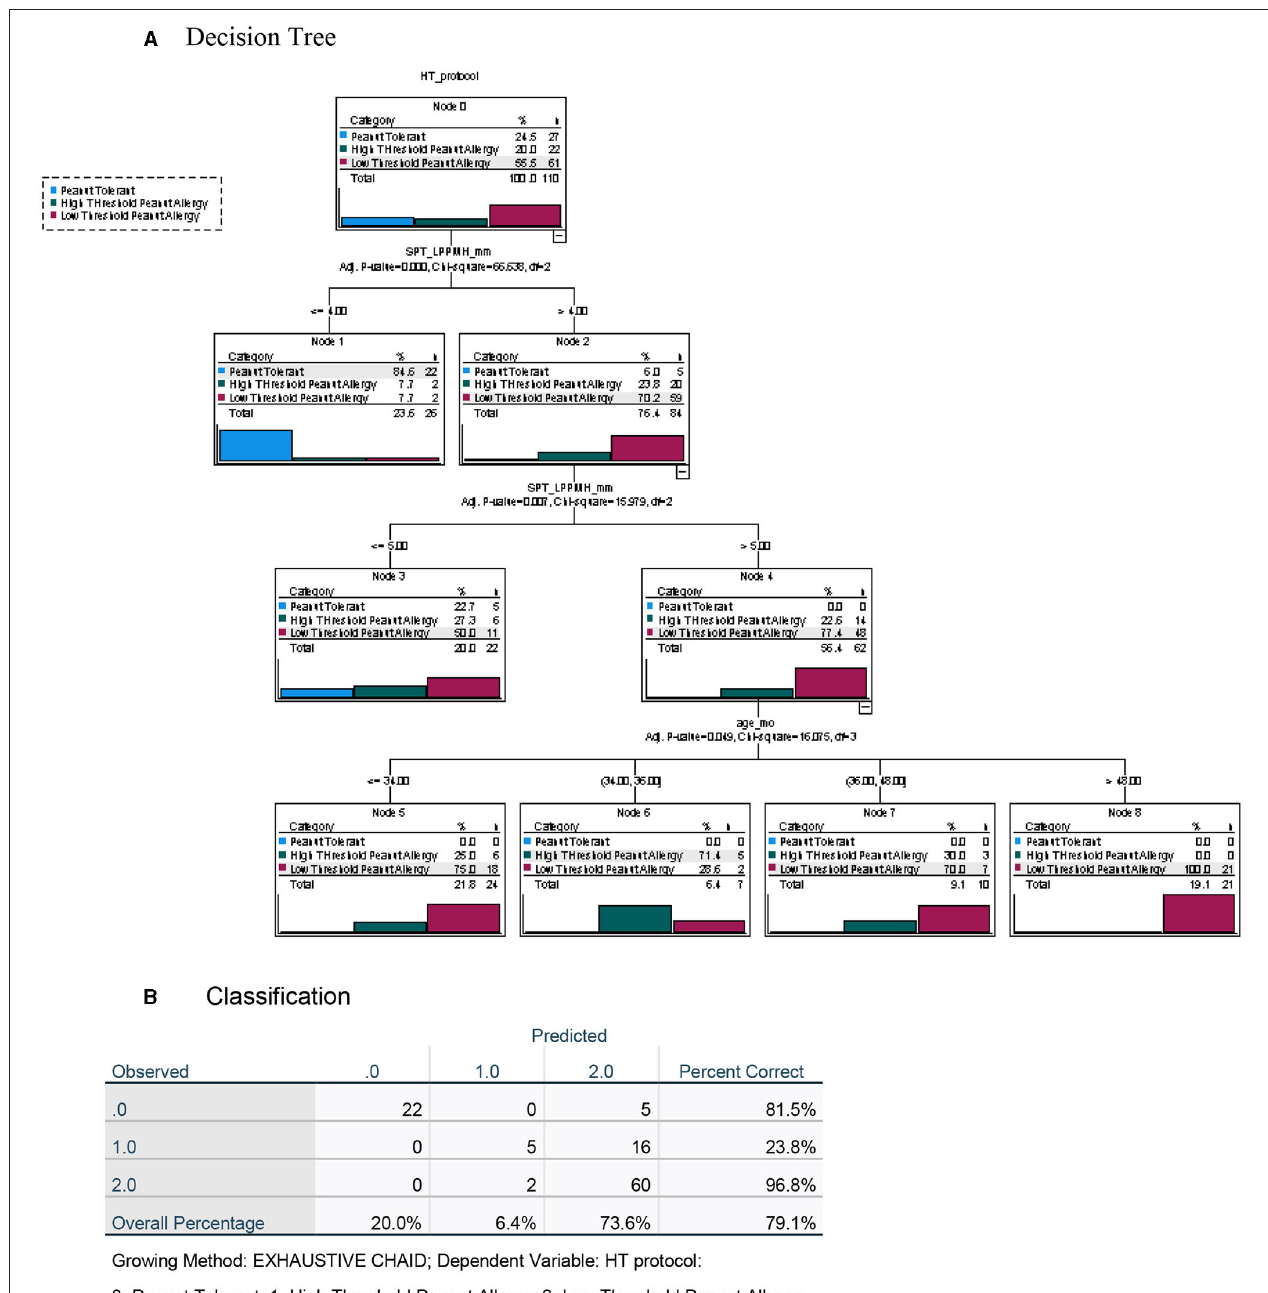
FIGURE 6 | Decision tree analysis for the classification of children with peanut tolerance and peanut allergy, with high ( > 300mg) or low ( < 300mg) threshold, including the data from the LPP-MH skin tests. (A) Decision tree and (B) Classification table. tests for peanut allergy, can tolerate the reintroduction of peanut proteins into their diet after resolving their allergy and, thus, can avoid adverse health outcomes associated with the false